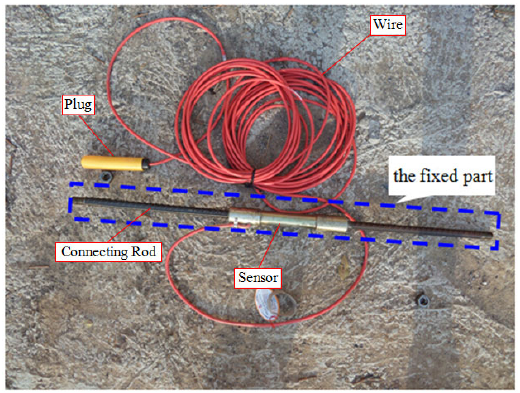
Figure 4. The details of the strain gauge.